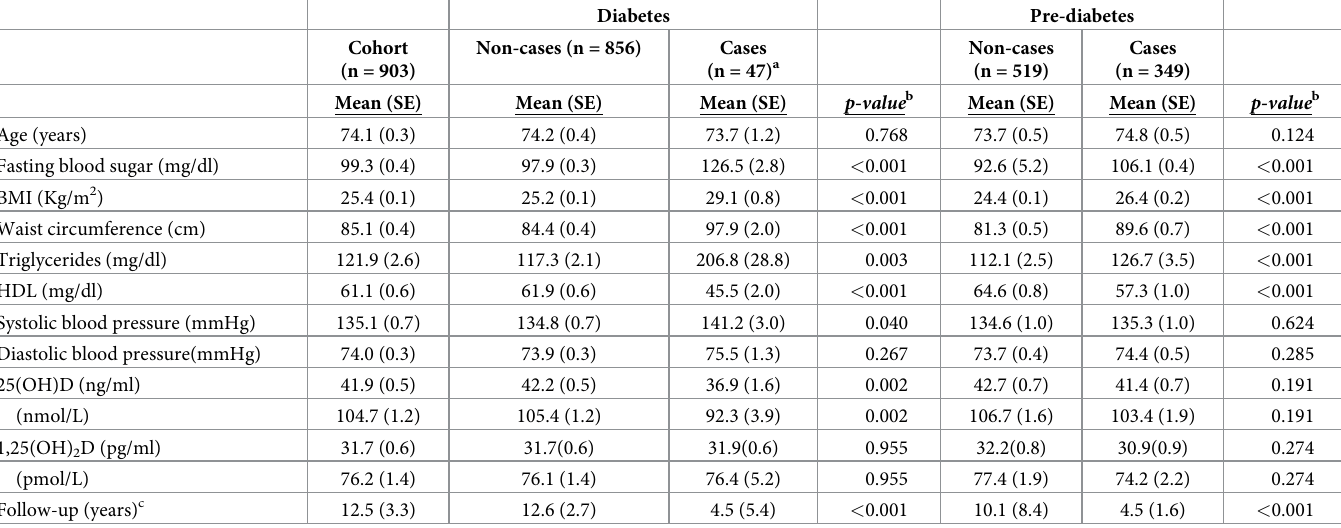
Table 1. Baseline characteristics of diabetes cases, pre-diabetes cases and non-cases in the Rancho Bernardo cohort,